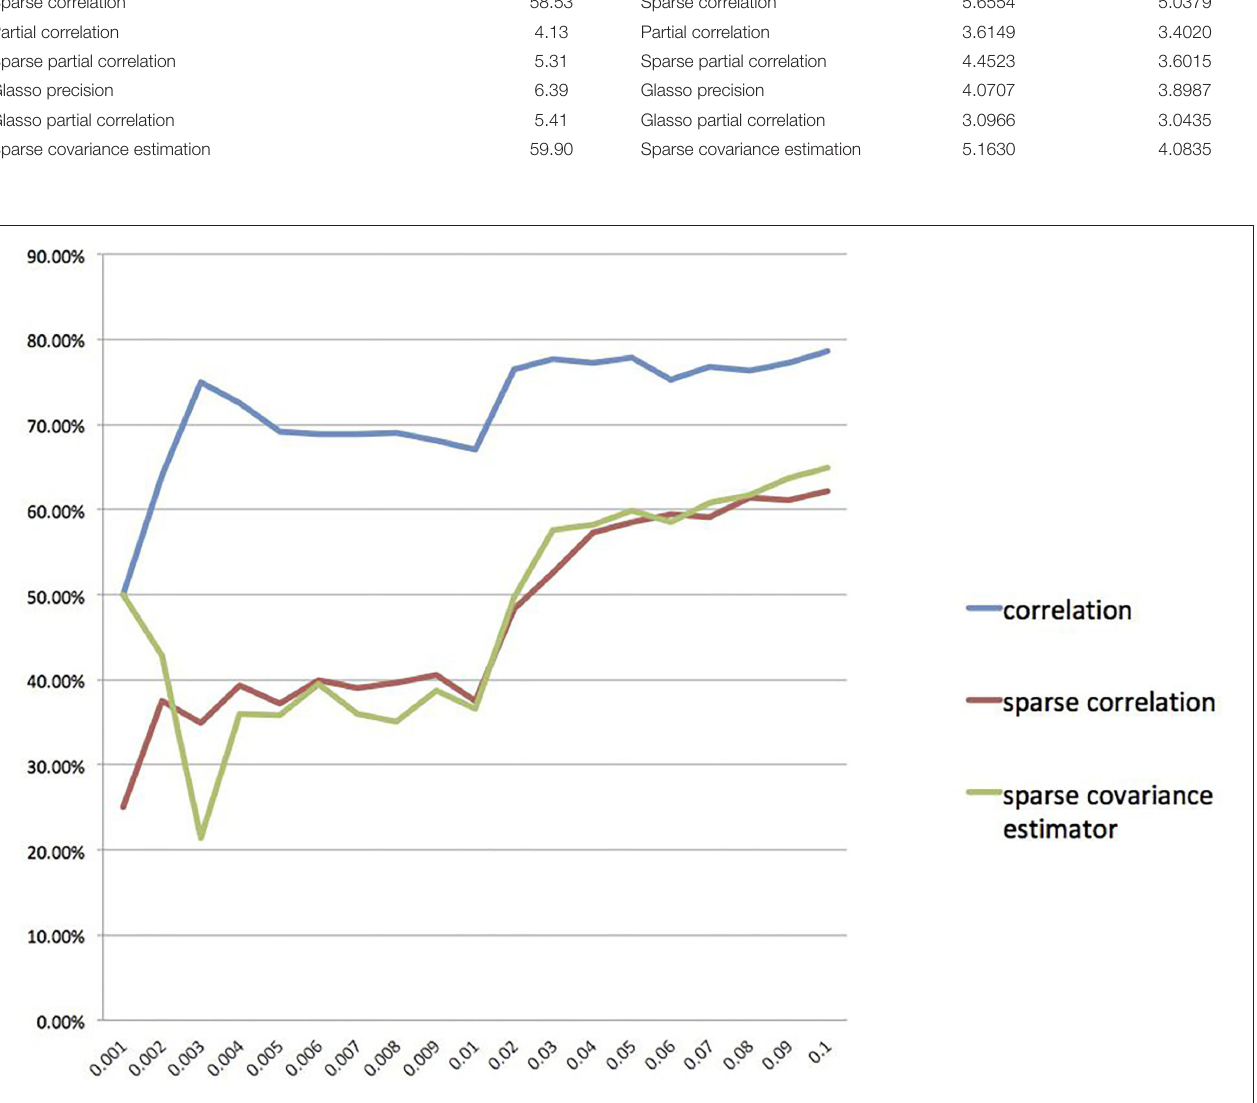
FIGURE 5 | Overlap rate for different threshold